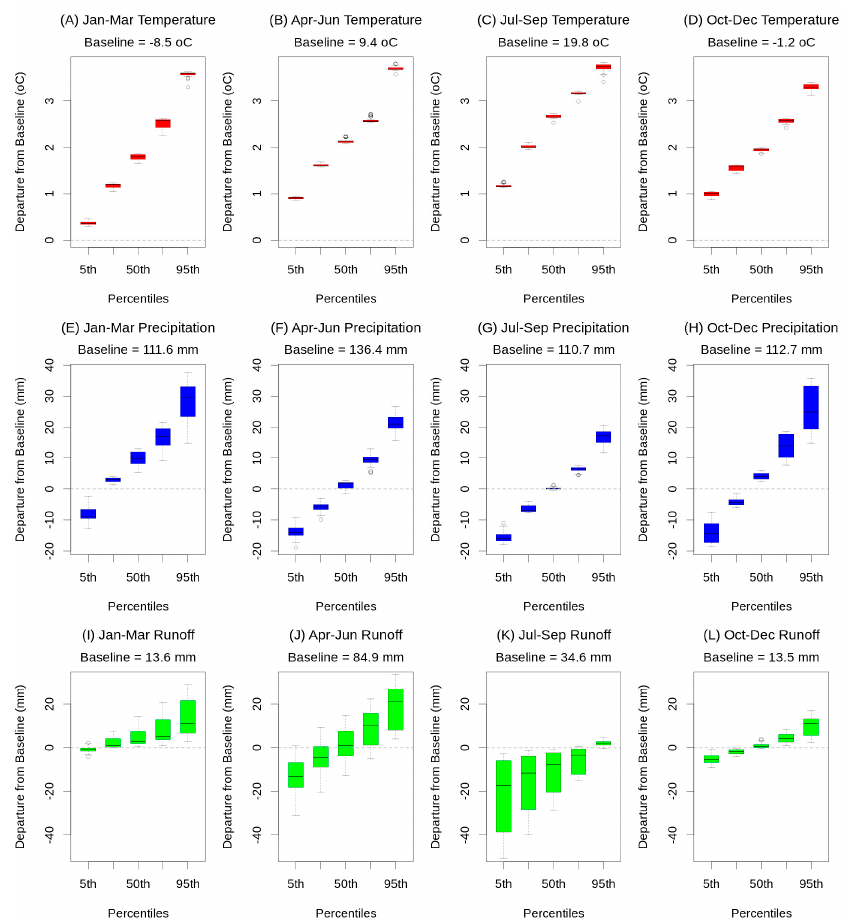
Figure 11. Boxplots showing the range of projected departures in seasonal average monthly temperature (in degrees Celsius °C), precipitation in millimeters (mm), and runoff (in mm) projected for 2030 for each HRU in Rocky Mountain National Park (ROMO) by percentiles (5th, 25th, 50th, 75th, and 95th) from 214 climate simulations HRU, Hydrologic response unit; Jan–Mar, January–March; Apr–Jun, April–June; Jul–Sep, July–September; Oct–Dec, October–December. See Figure 9 caption for a full description of box and whisker statistics.